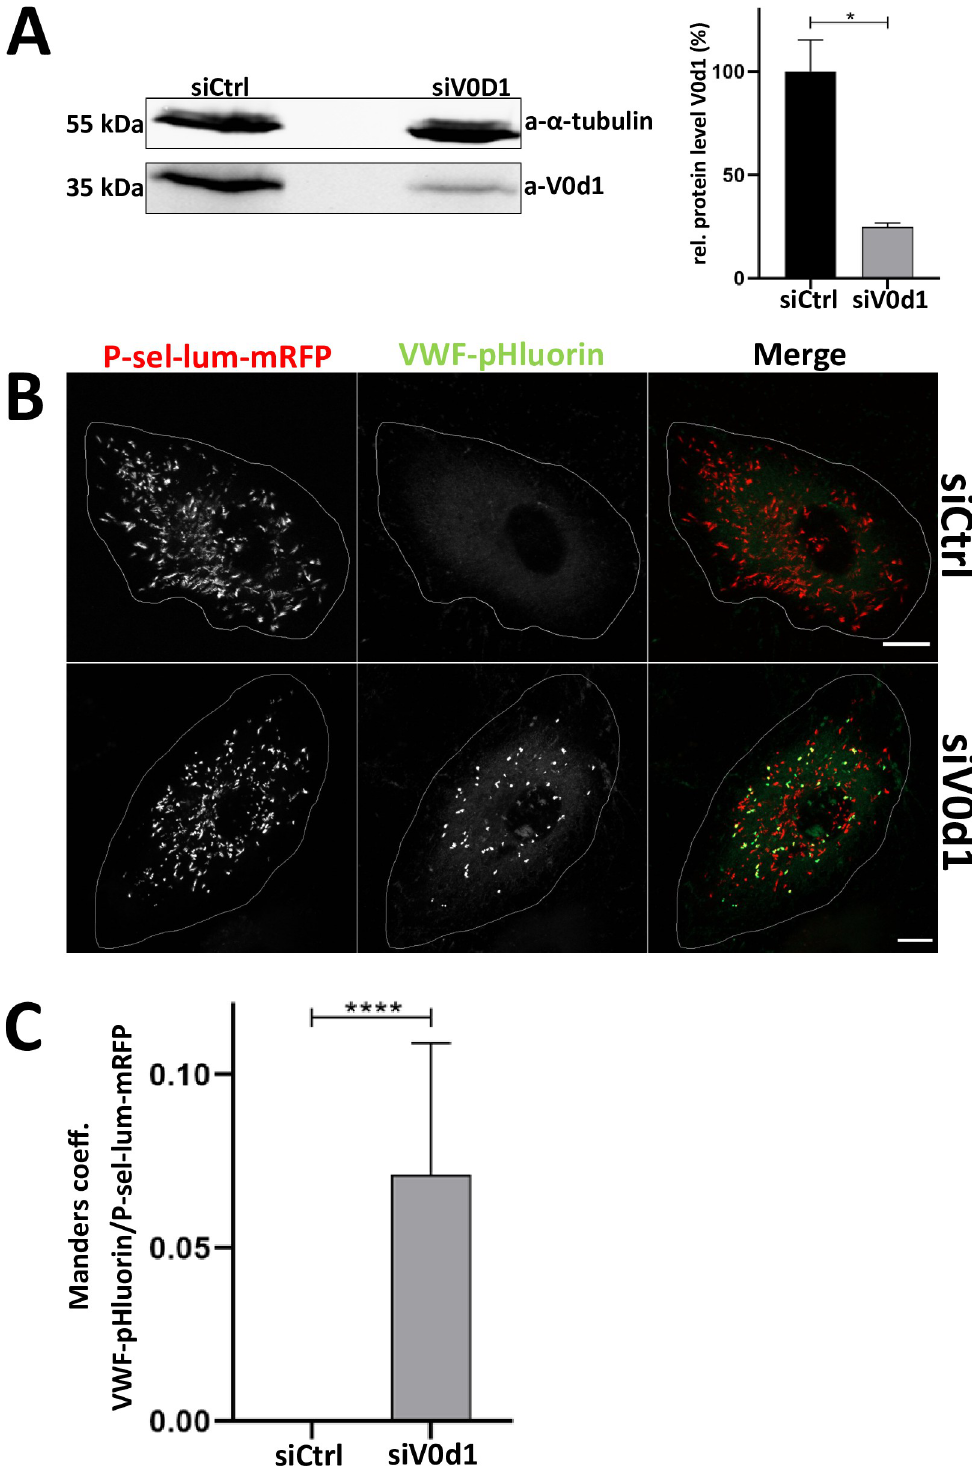
Fig 4. Knockdown of the V-ATPase subunit V0d1 prevents acidification of WPB. HUVEC were transfected with the respective siRNA, P-sel-lum-mRFP and VWF-pHluorin. A. 24 h later cells were lysed and subjected to Western blot analysis with anti-V0d1 antibodies. Probing with anti-tubulin antibodies served as loading control. One representative blot is shown on the left. Right, V0d1 band intensities of 3 blots were measured and normalized to intensities of the loading